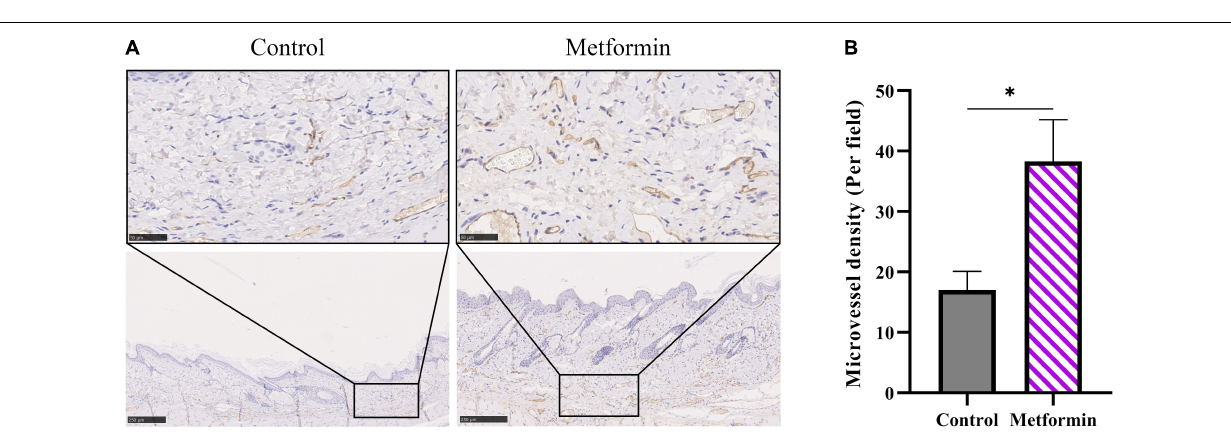
FIGURE 7 | IHC staining of CD31 in mechanically stretched skin. (A) IHC staining revealed more CD31+ vessels in mechanically stretched skin from the metformin-treated group relative to the control group. (B) Quantitative analysis of microvascular density. ∗ p <